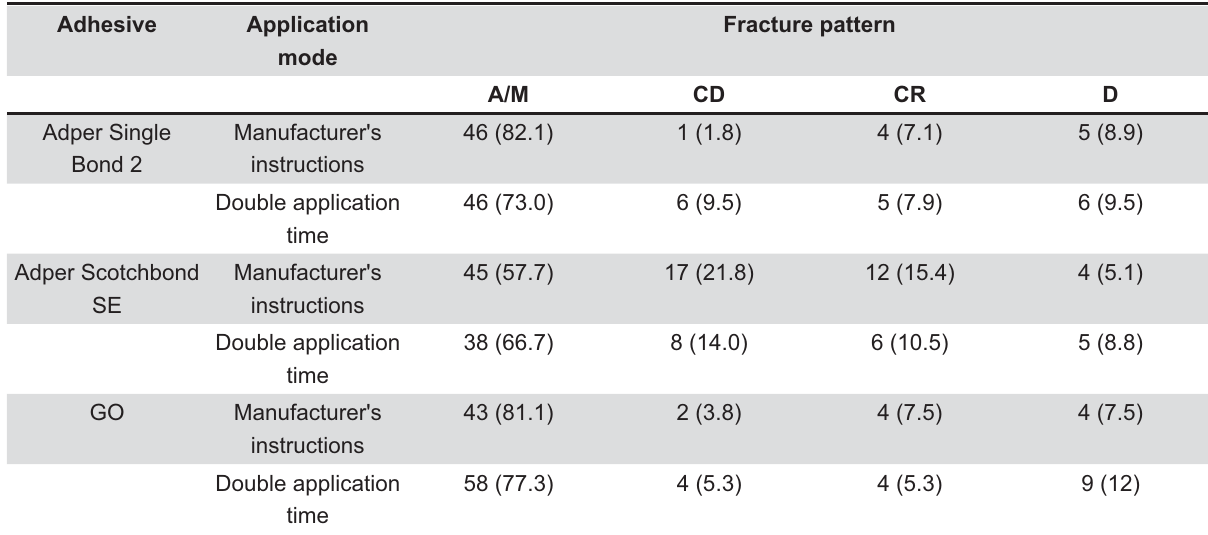
(*) A/M – adhesive/mixed fracture mode; CD – cohesive fracture mode in dentin; CR – cohesive fracture mode in resin; PF – premature failures.